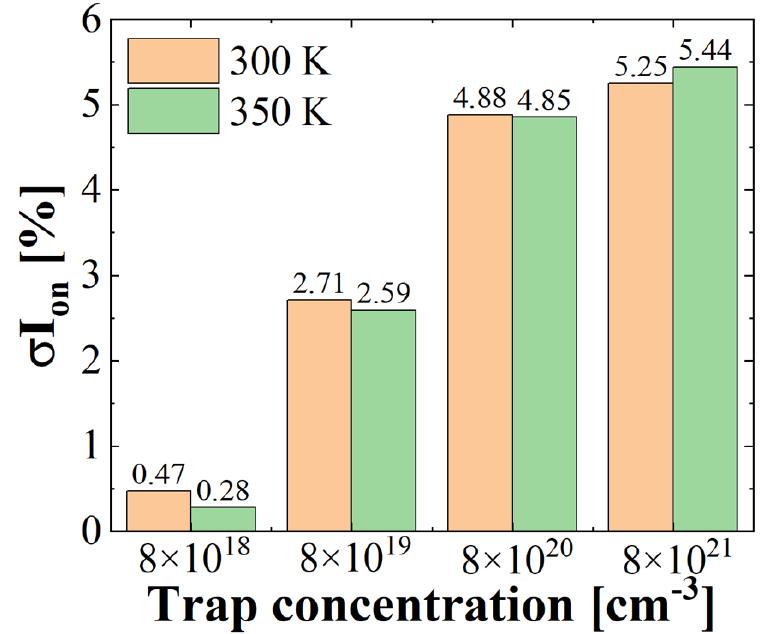
Figure 5. Rate of I on degradation with different temperatures and trap concentrations. Displacement defect is located at the worst position as shown in Figure 3.